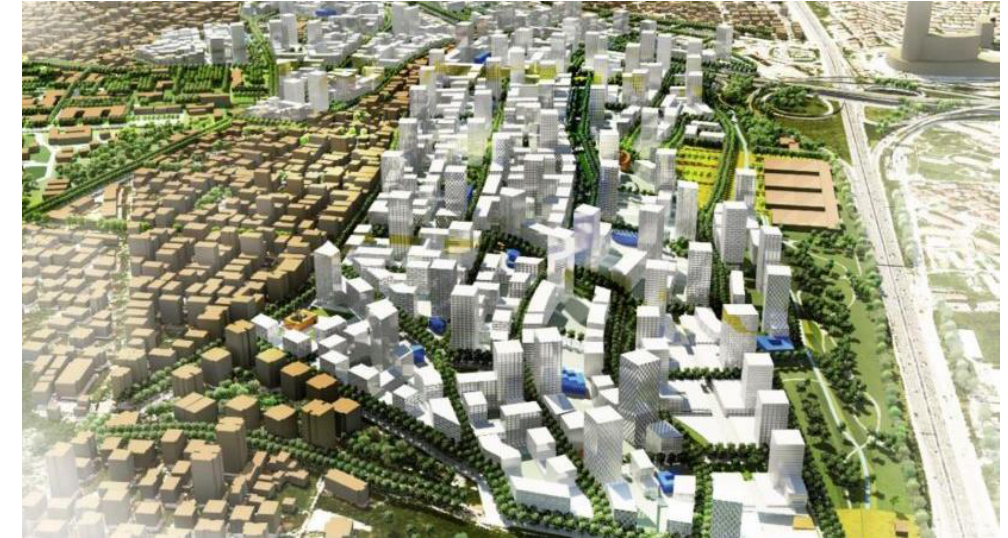
Figure 3: The Structure in Fikirtepe following